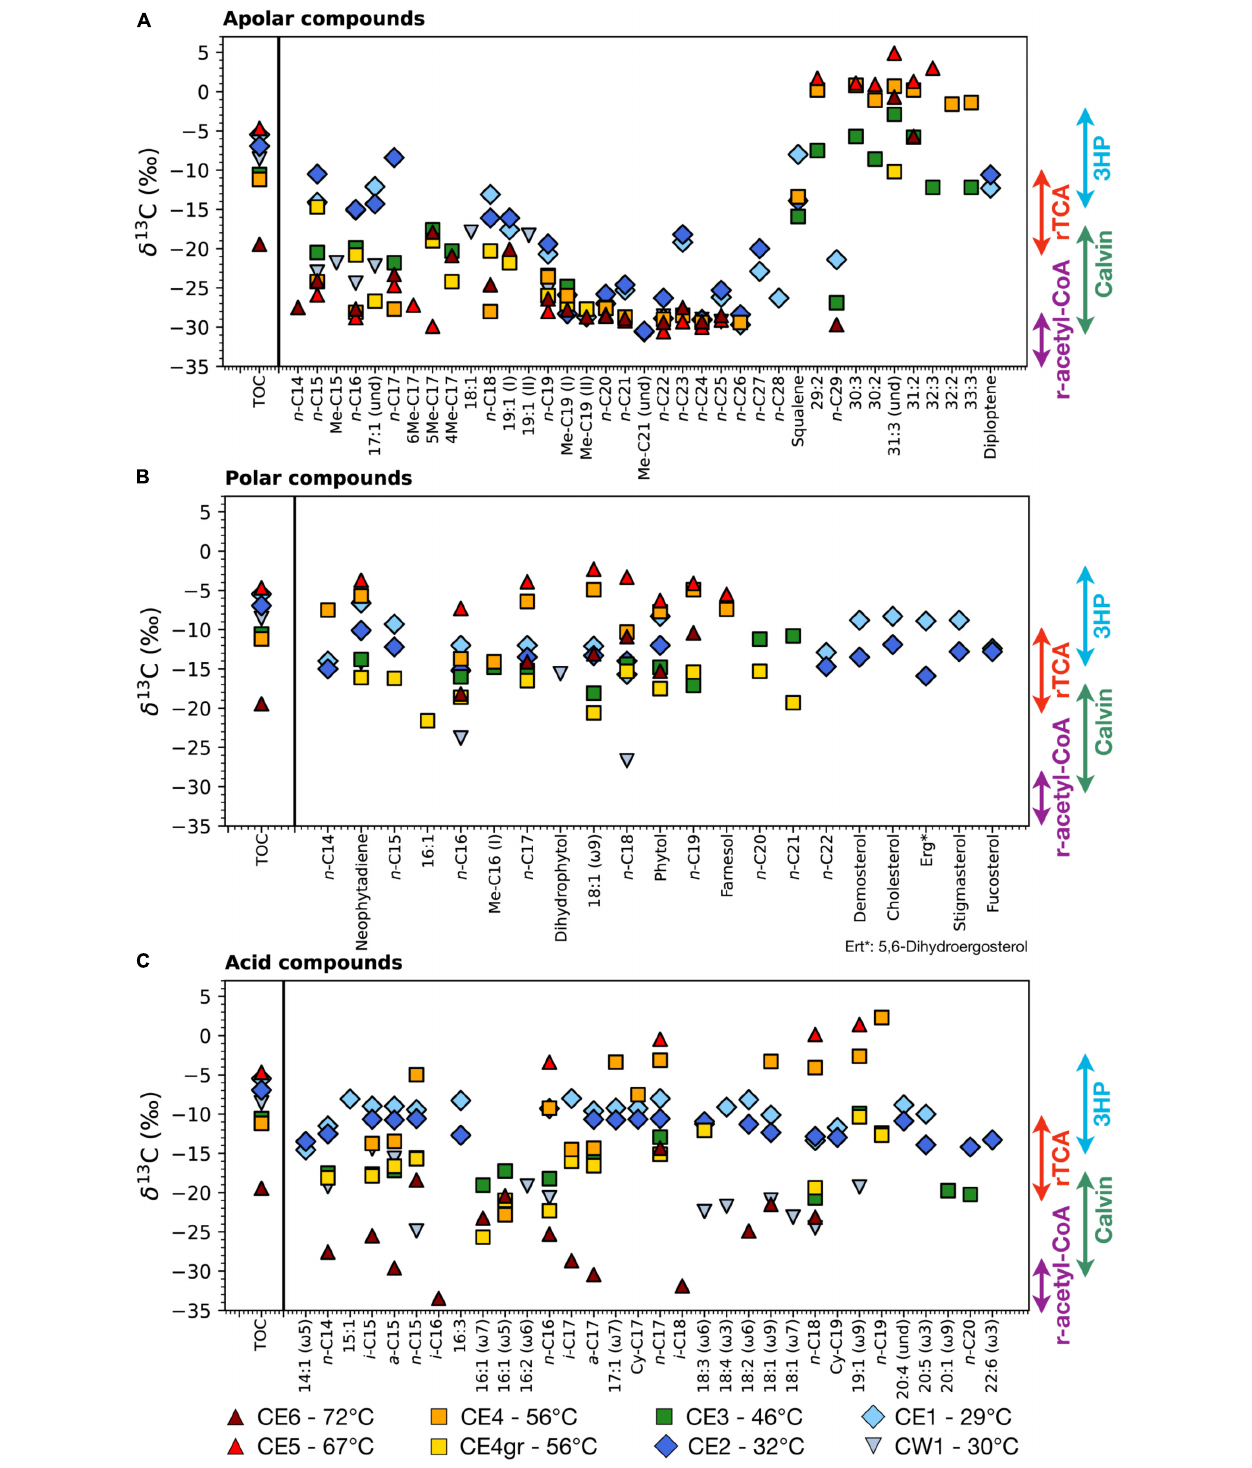
FIGURE 3 | Compound-specific isotopic composition ( δ 13 C) of the lipid compounds identified in the three polarity fractions; (A) apolar, (B) polar, and (C) acidic. The isotopic composition of the total biomass ( δ 13 C TOC ) is shown in each fraction for comparing the isotopic composition of the bulk cell material with that of individual lipid compounds. Colored arrows represent canonical biomass δ 13 C values associated with the four primary carbon fixation pathways (Preuß et al., 1989; van der Meer et al., 2000; Hayes, 2001). Note that individual lipid compounds are typically lighter (i.e., more negative δ 13 C) than the bulk organic matter, except for those synthesized through the reductive tricarboxylic acid (rTCA) cycle and, sometimes, the 3-hydroxypropionate (3HP) bicycle (Meyers, 1997; Jahnke et al., 2001).